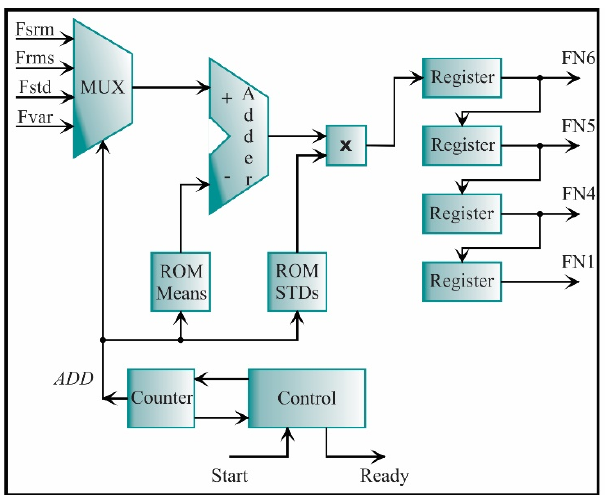
Figure 20. Architecture for computing the feature normalization of 4 features.